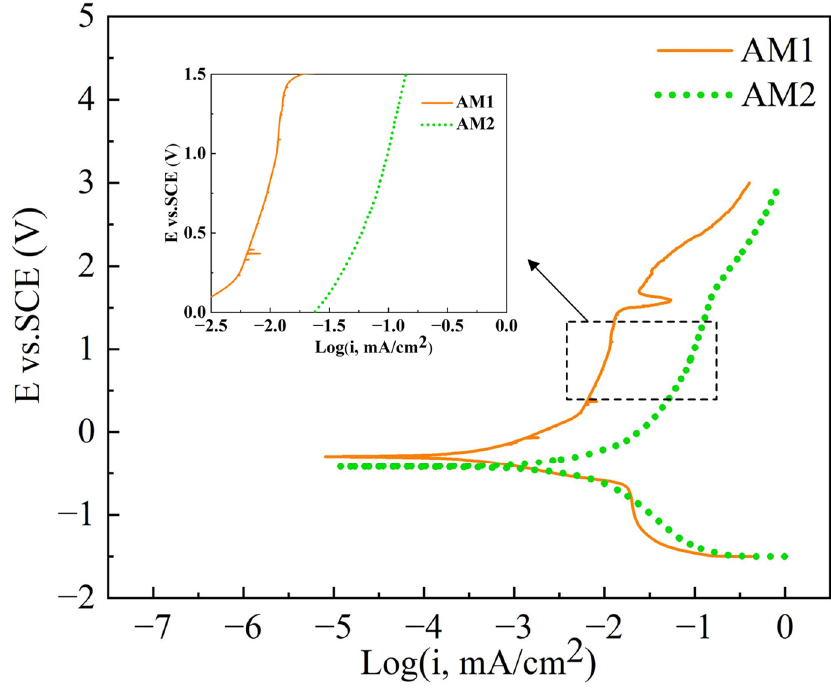
Figure 2. Potentiodynamic polarization curves. Table 3. The corrosion potential, corrosion current density and passive current density.